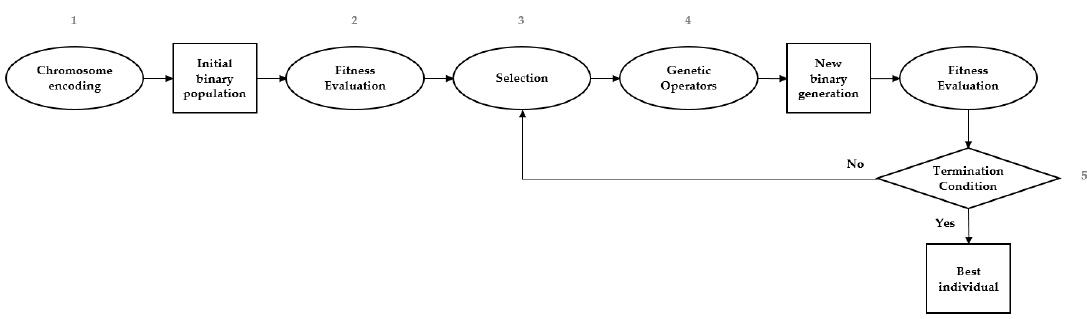
Figure 6. GA-Based Feature Selection.